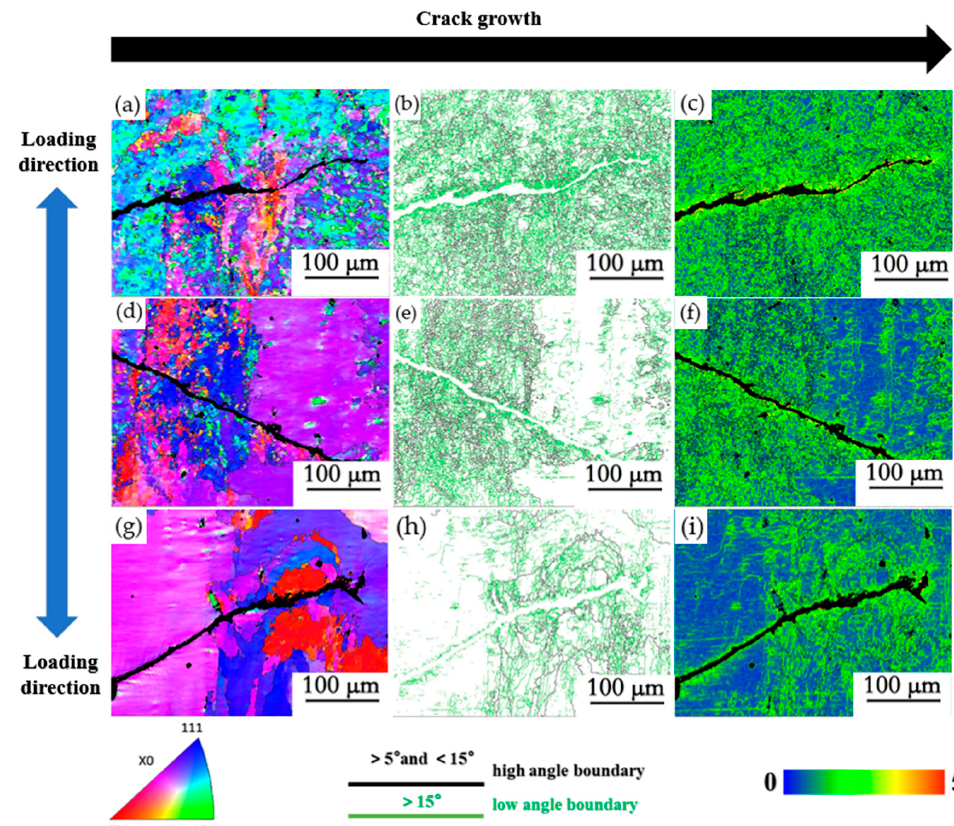
Figure 7. ( a , d , g ) IPF diagram of EBSD results of corrosion fatigue crack growth path of A7N01P-T4 aluminum alloy with different degrees of fatigue damage; ( b , e , h ) grain boundary distribution topography; ( c , f , i ) KAM diagram and its data.